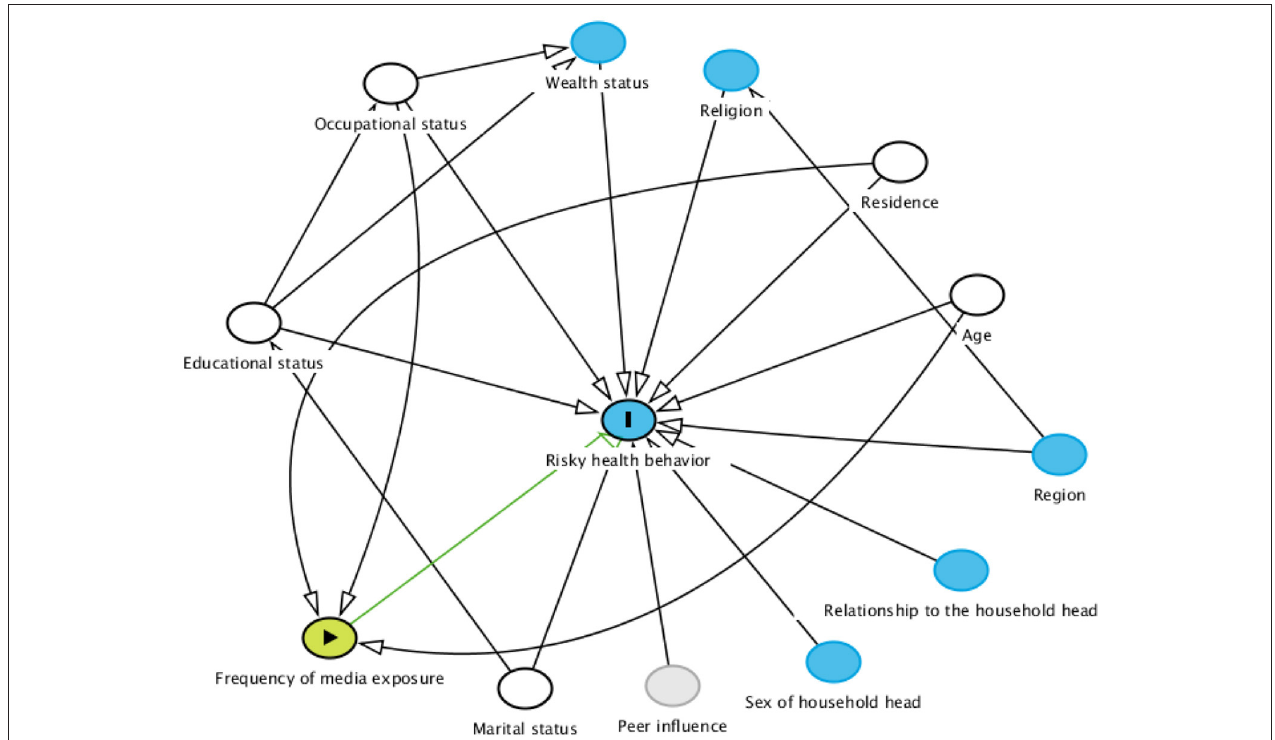
FIGURE 1 | Hypothesized model for factors associated with risky health behavior among males in